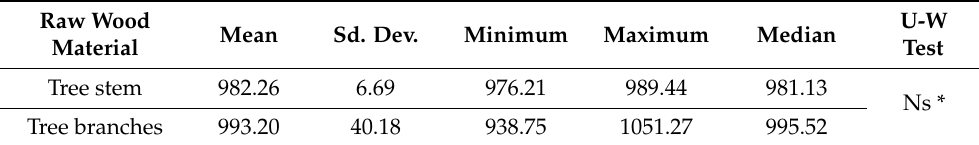
Table 2. Basic statistics of green density (kg/m 3 ) of raw wood material collected from tree stems and branches of wood.